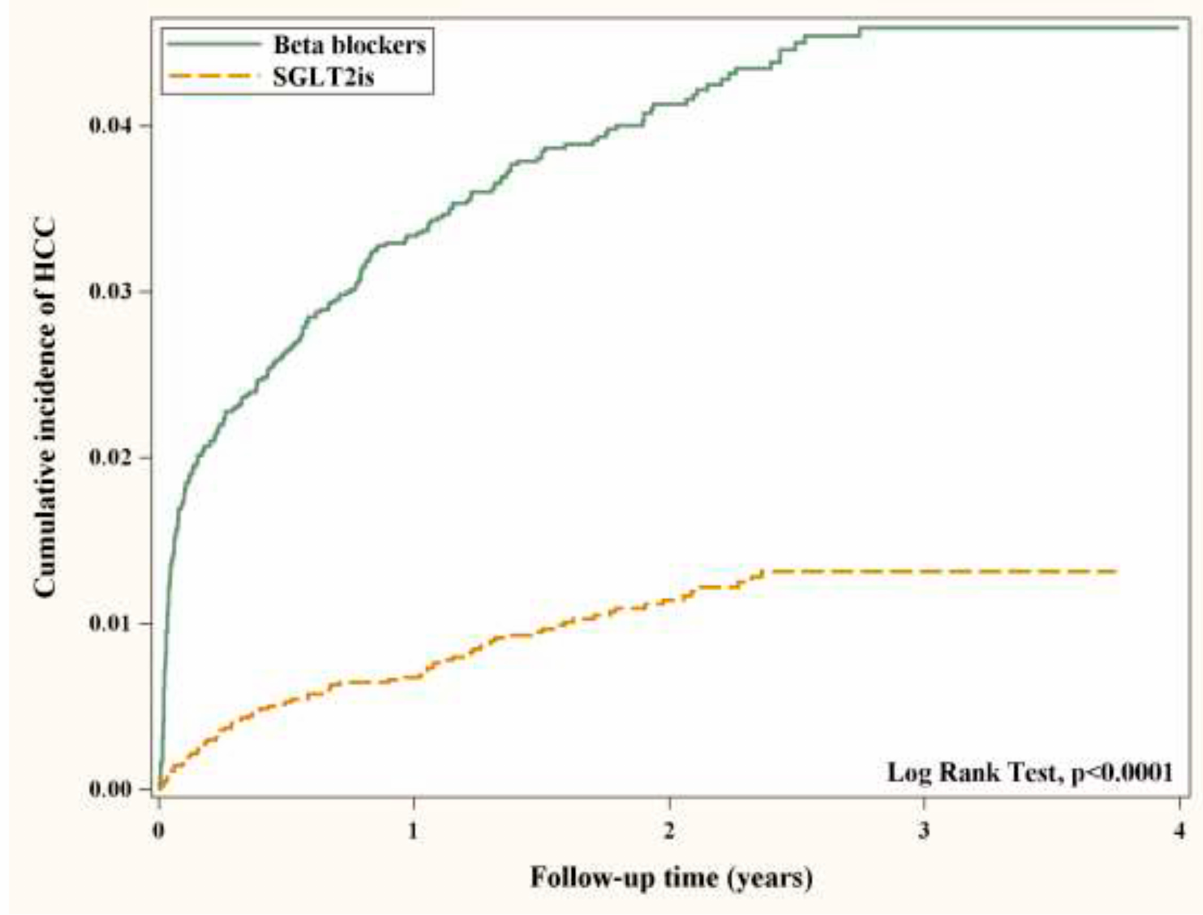
Figure 1. Cumulative incidence of HCC in SGLT2I and β -blocker users.